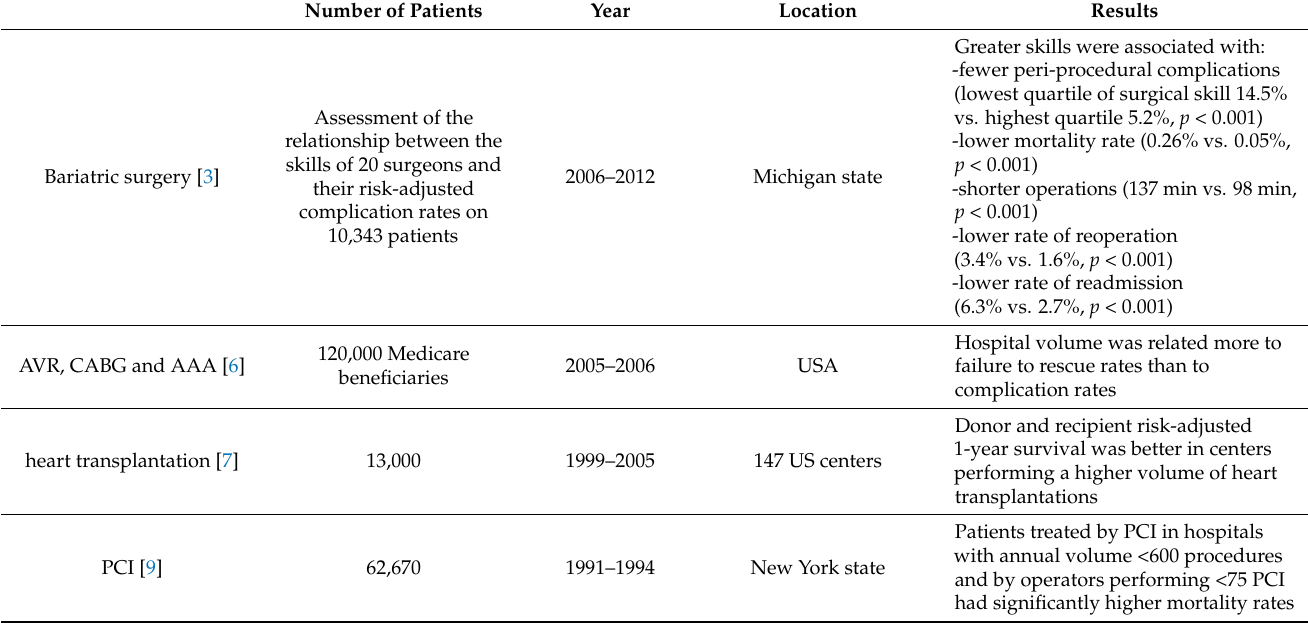
Table 1. Studies assessing the volume-outcome relationship for non-valvular procedures.